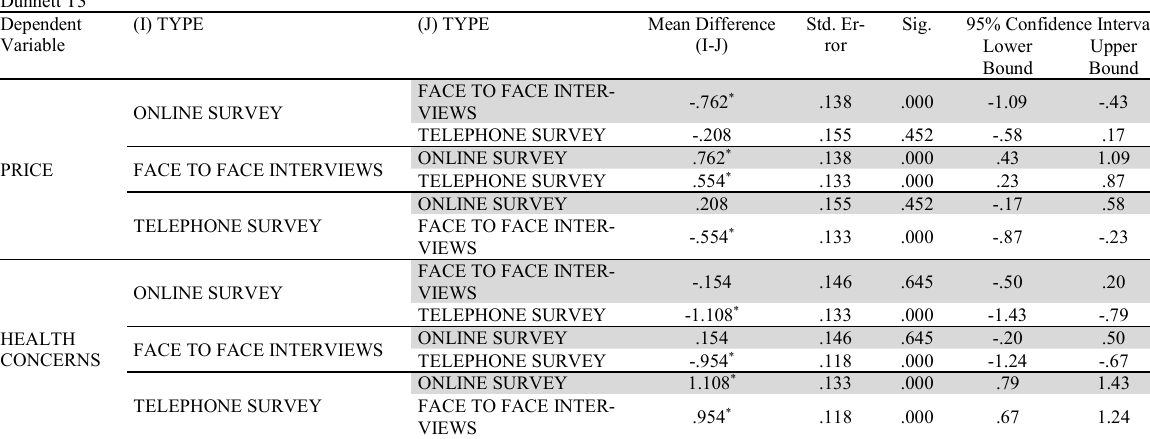
Multiple Comparisons of Promotion schemes Dunnett T3 Dependent Variable